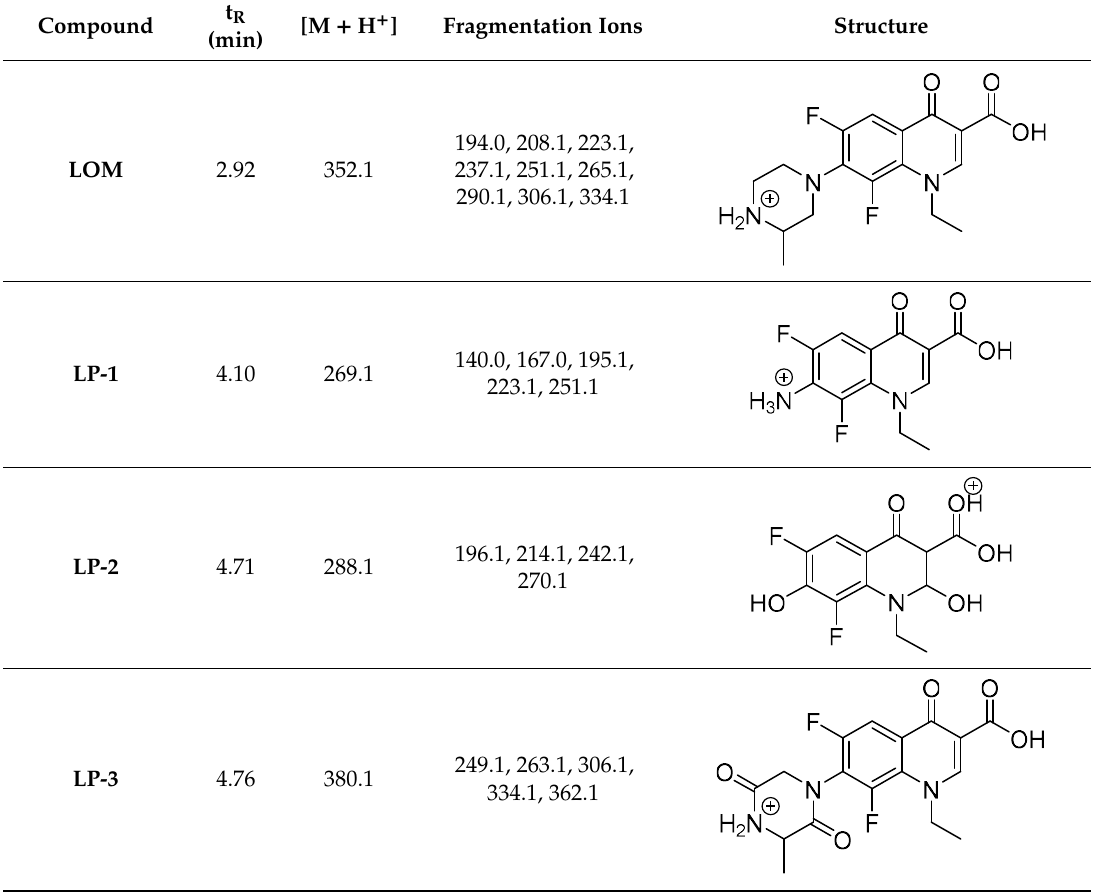
Table 5. Proposed structures of the degradation products of LOM formed under the influence of ACVA.